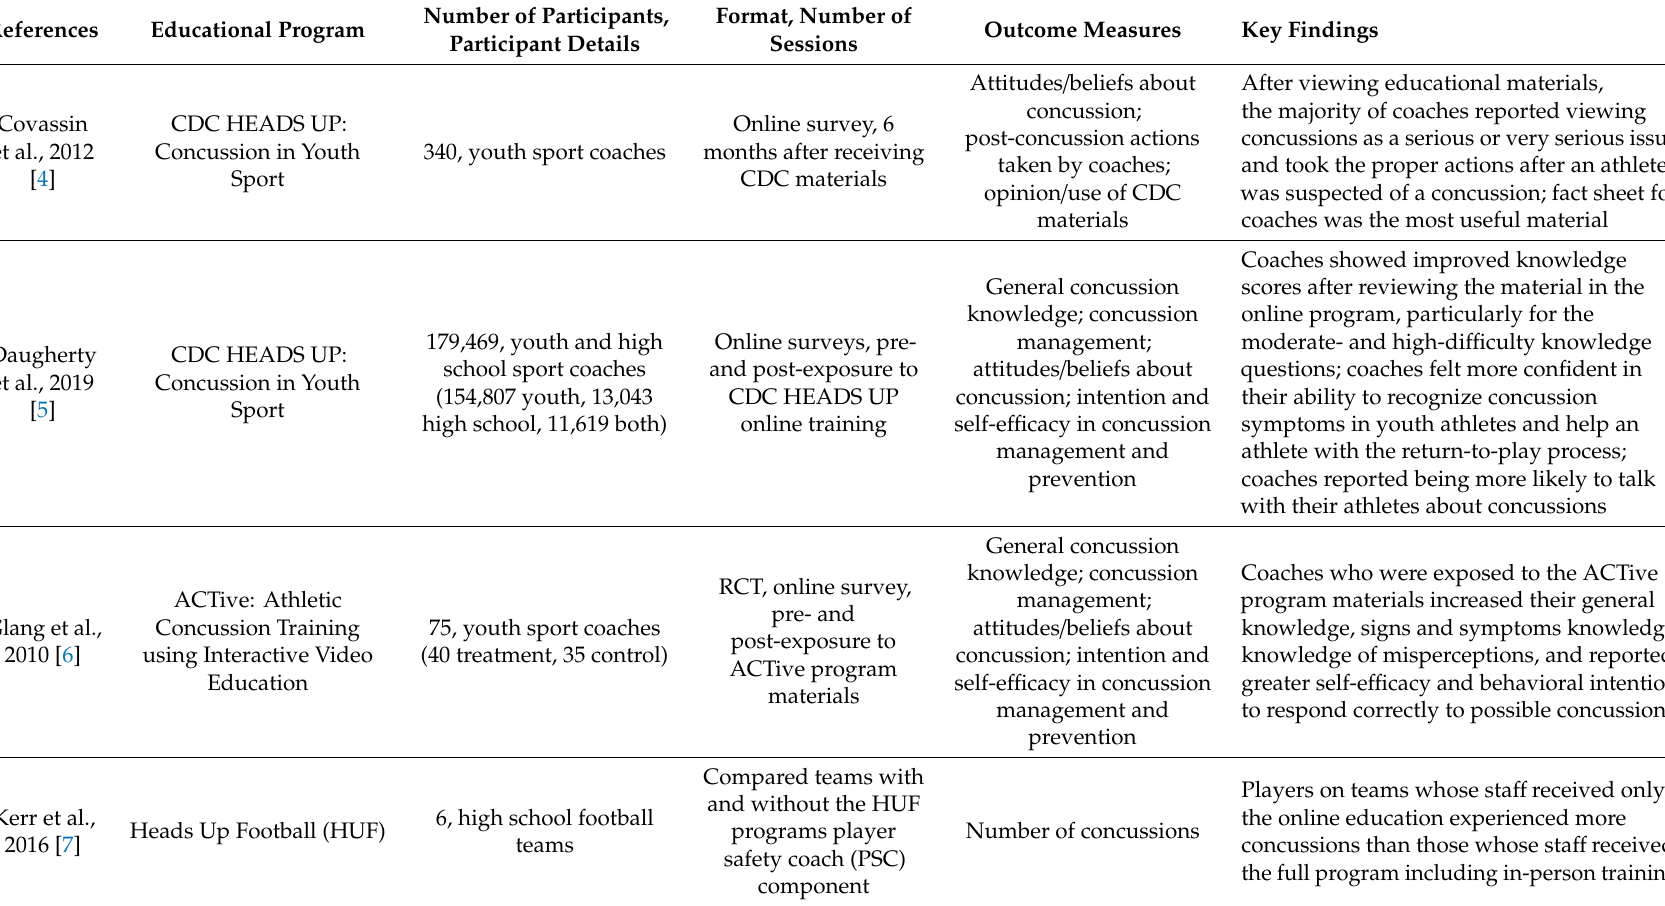
Table 1. Study Characteristics and Key Findings Regarding the E ff ectiveness of Concussion Education Programs ( N =